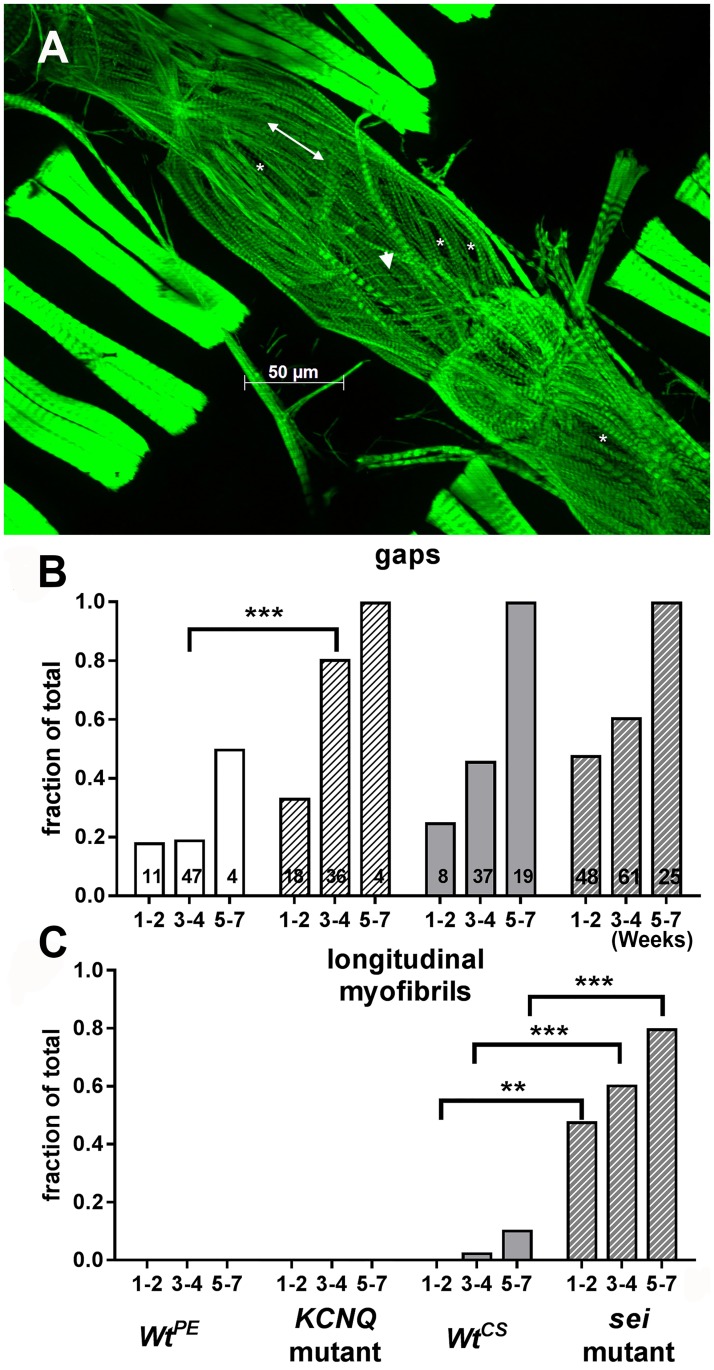
Morphological remodeling in seizure mutants.(A) A full projection Z stack of a heart from a 1 week old sei mutant stained with phalloidin for F-actin is shown. (B) Hearts were scored for presence of gaps (*in A) or (C) longitudinally oriented myofibrils (double headed arrow in A). Note also the presence of very thin myofibrils (arrow head in A, for wt structures see Fig 6B). Ages are in weeks; numbers of hearts examined are indicated in each bar in B. Significance was determined using multiple T-tests comparing each mutant with its genetic background control at each age; **p<0.01, ***p<0.001.